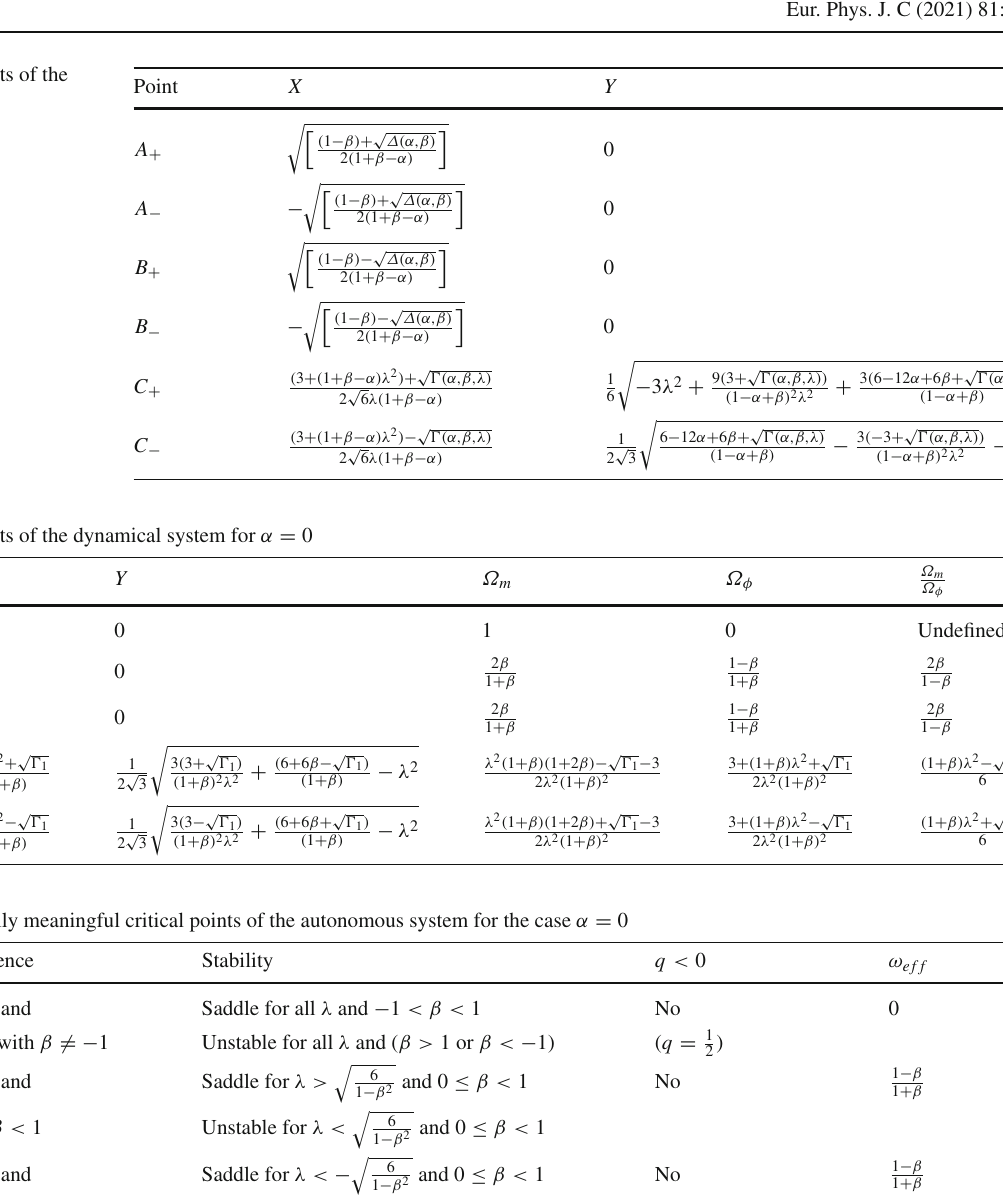
Saddle in all region i in Fig. 1